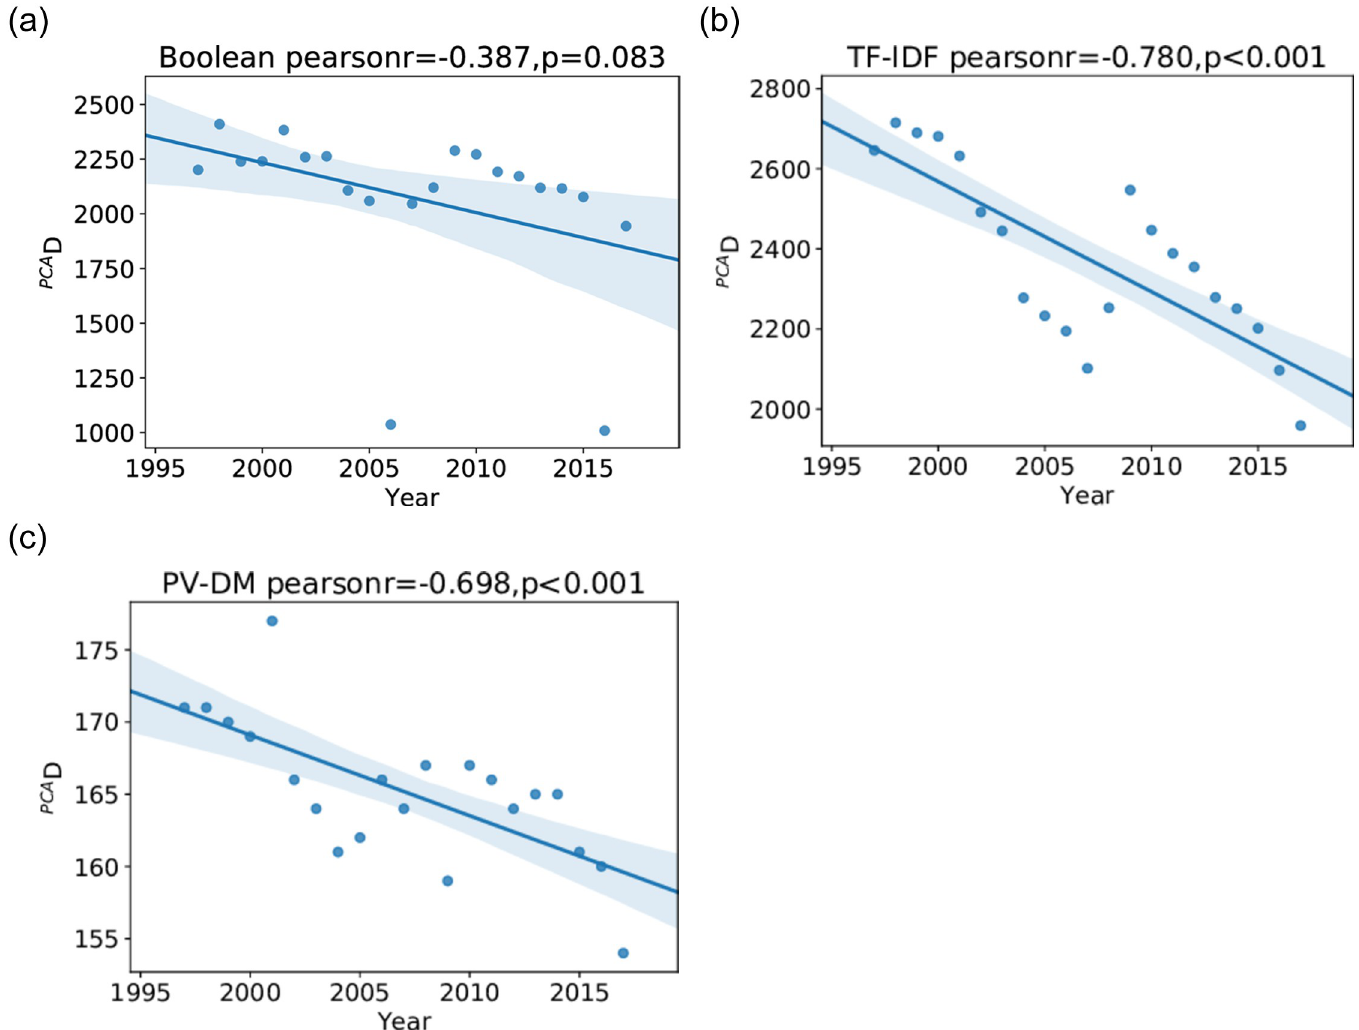
Fig 11. Annual number of dimensions required to account for 90% of variance of document vectors when embedded in the Boolean (left), TF-IDF (middle), and PV-DM (right) models. For each model we show a scatter plot of annual diversities and a linear regression fit with its 90% confidence interval.